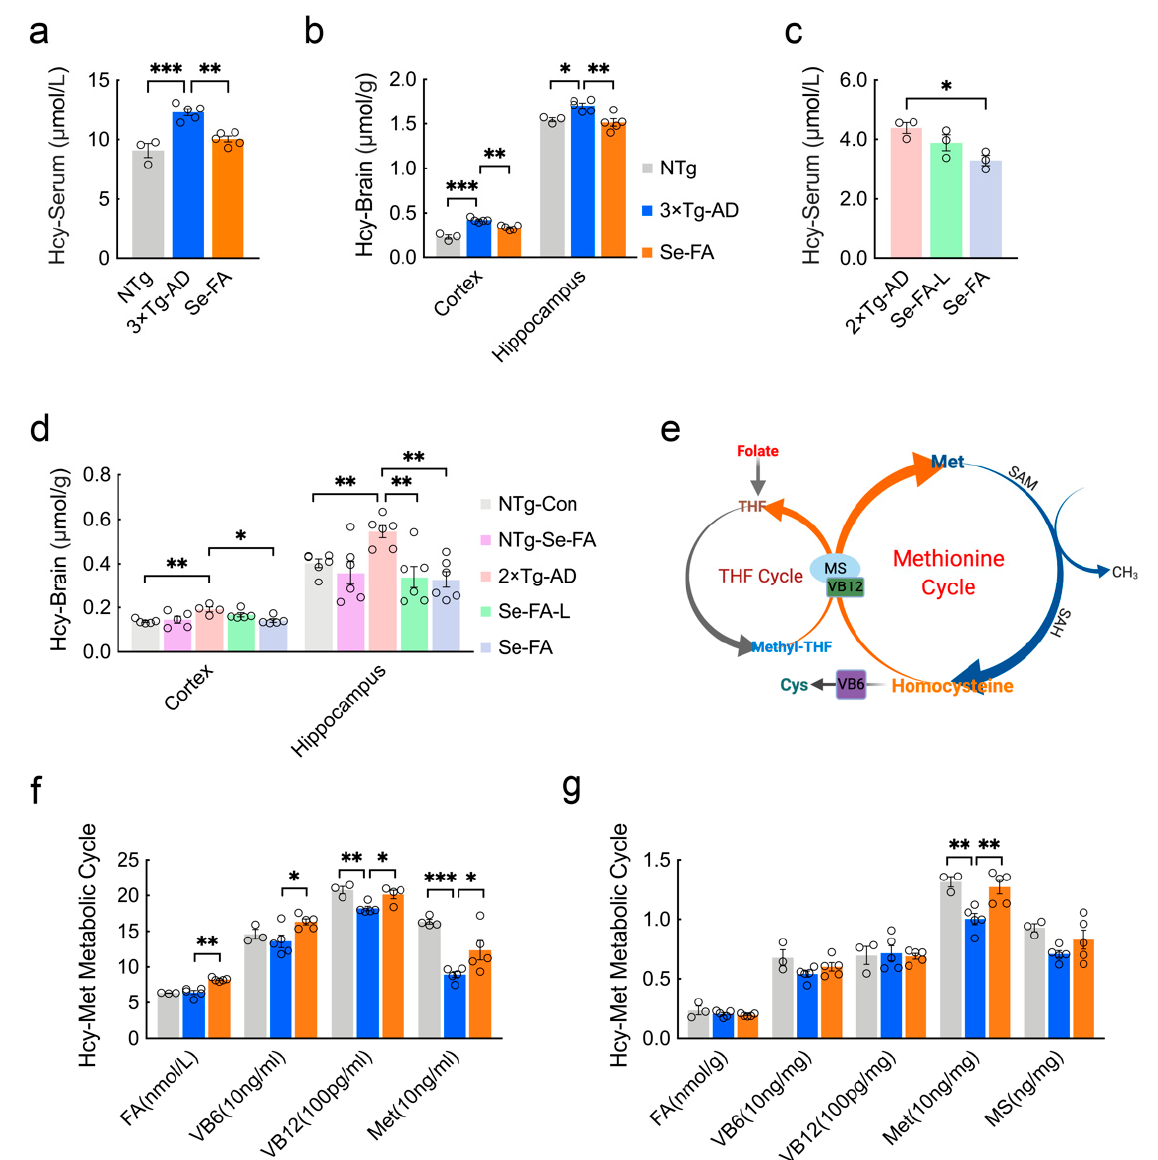
Figure 1. Se-FA reduces Hcy levels and increases Met levels in 3 × Tg- and 2 × Tg-AD mice. ( a – d ) Hcy levels in the serum ( a , c ), cortex and hippocampus ( b , d ) of 7-month-old 3 × Tg- and 2 × Tg-AD mice measured by ELISA (n = 3 or 6 mice). Se-FA: normal-dose Se-FA (Se 3 µ g/g and folate 36 µ g/g). Se-FA-L: low-dose Se-FA, half of normal-dose Se-FA. ( e ) A pattern of THF and Met cycles in the metabolism of Hcy. ( f , g ) Levels of FA, VB6, VB12, Met and MS in the serum ( f ) and cortex ( g ) of 7-month-old 3 × Tg-AD mice (n = 3, 4 or 5 mice). All the mice were fed diets with Se-FA or a control diet for 12 weeks. All data are presented as the mean ± SEM. * p < 0.05, ** p < 0.01, *** p < 0.001 as determined by one-way ANOVA followed by Dunnett’s multiple comparison test.